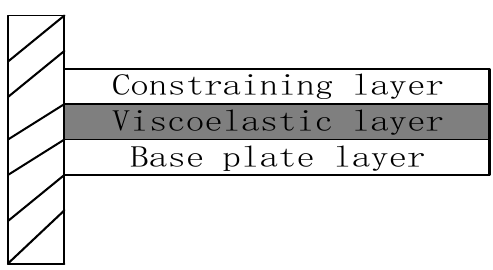
Figure 1. Constrained damping sandwich panels.